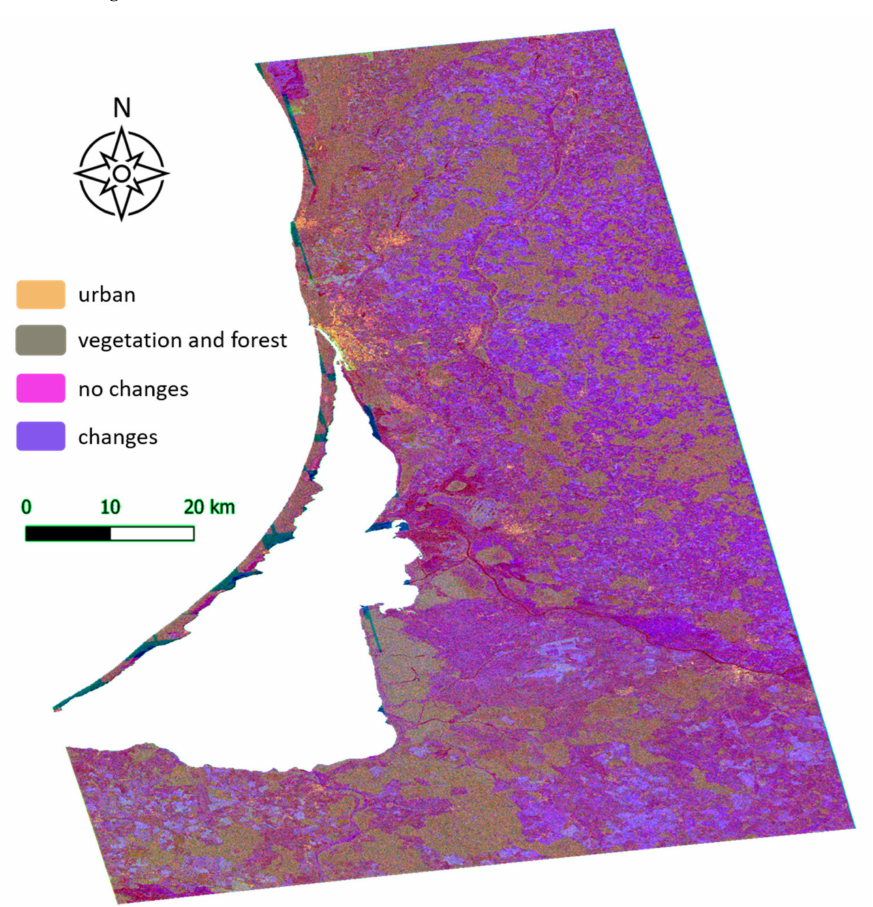
Figure 10. Land cover changes were identified using SAR image coherence. Yellow—urban areas, green—vegetation areas and forests, magenta—no change and blue—changed